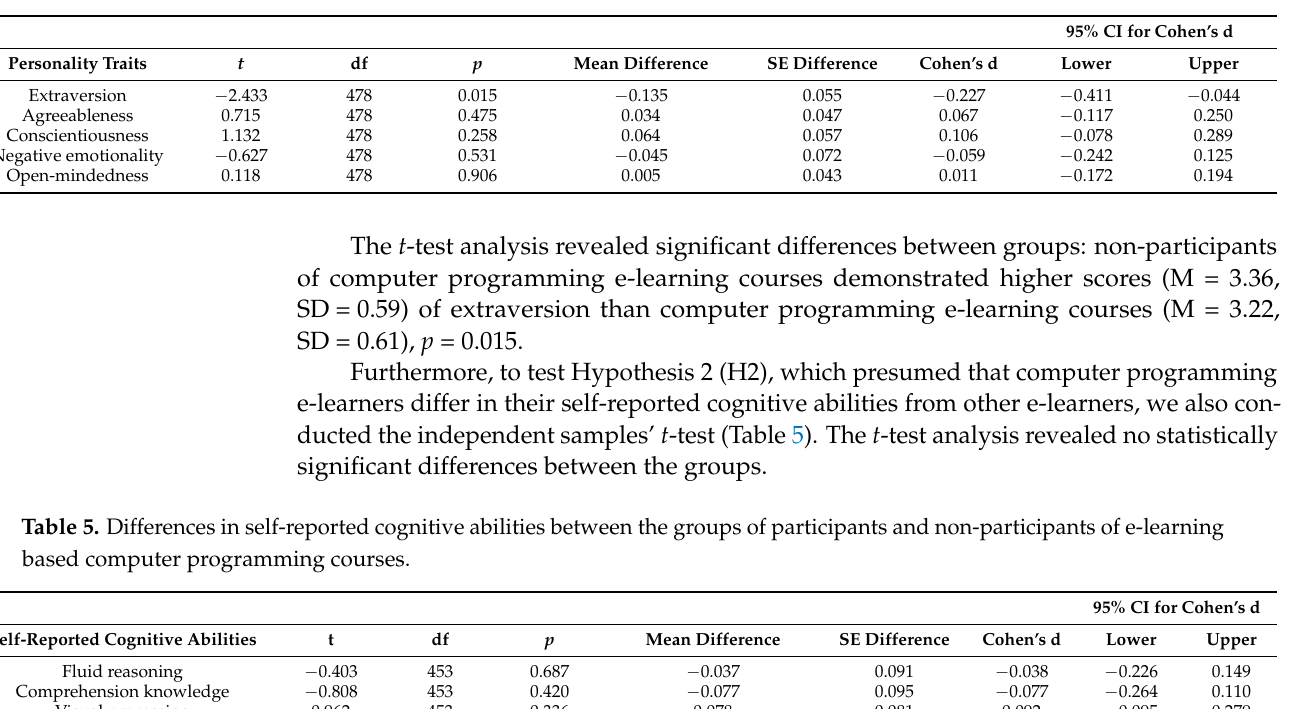
Table 4. Differences in personality traits between the groups of participants and non-participants of e-learning based computer programming courses. Personality Traits